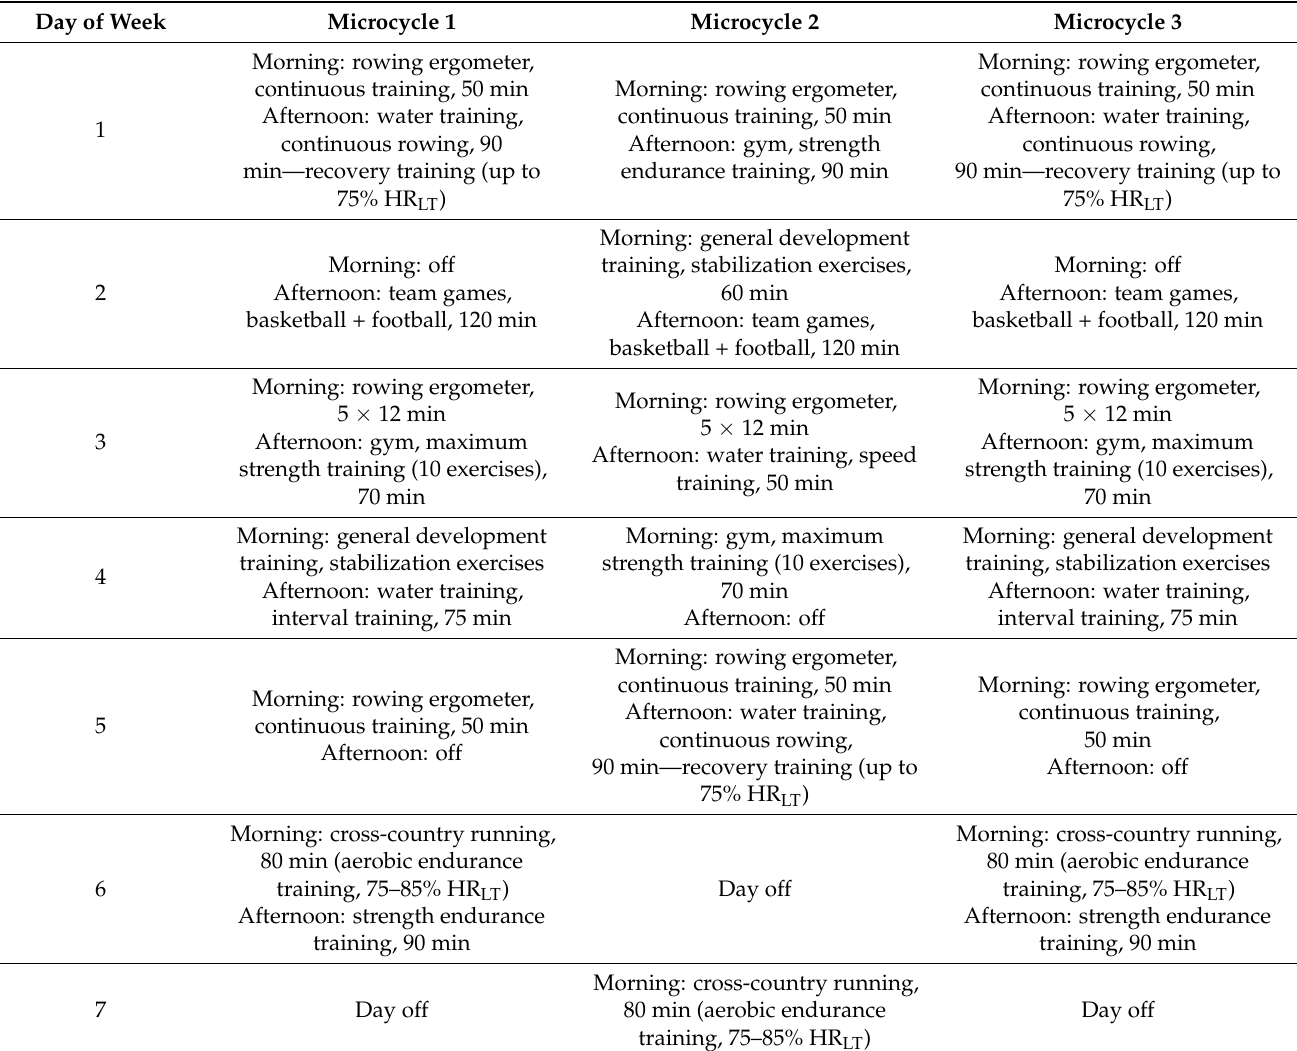
Table 2. The 3-week training